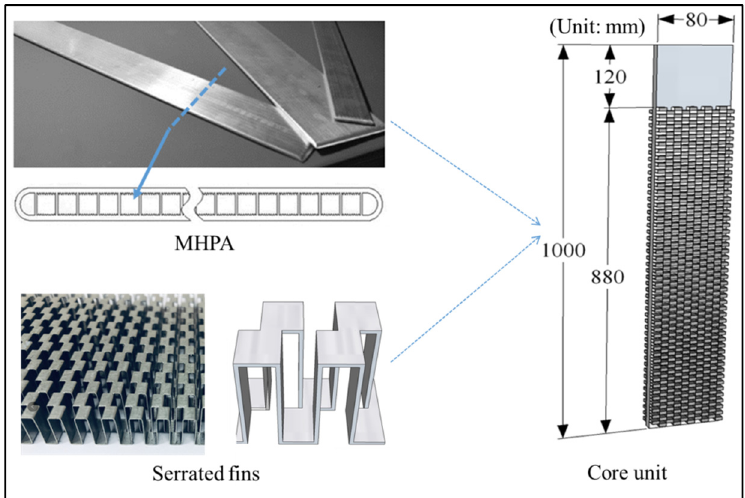
Figure 2. Core heat transfer component of MHPA–AWHE.